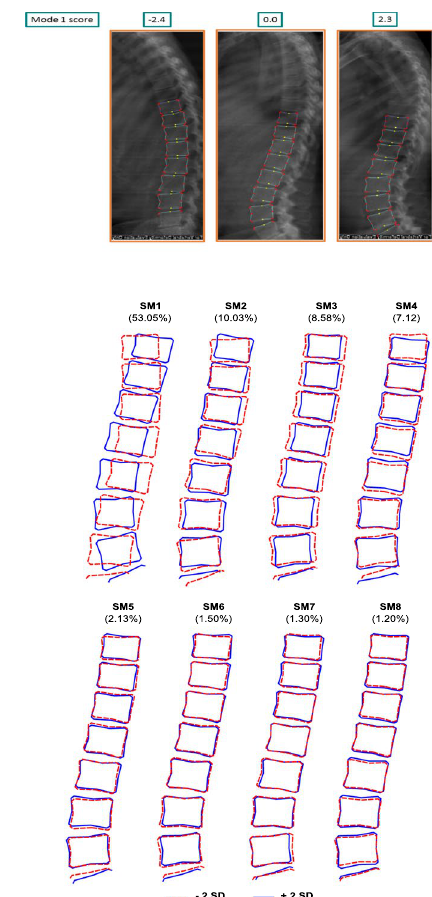
Figure 1. ( a ) Shows representative DXA images of the NSHD cohort sorted by their spine mode (SM) 1 score, with the template used to mark the anatomical landmarks of the vertebral bodies overlaid onto the image and ( b ) illustrates the variation in lumbar spine shape and the percentage variance detected by spine modes (SM) 1 to 8 shown as ± 2 SD from the mean of zero for the whole